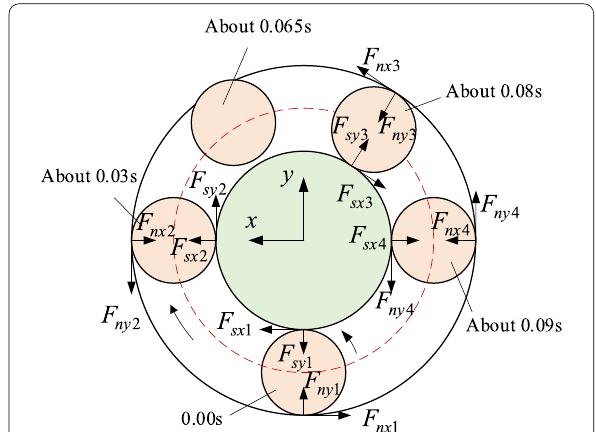
Figure 29 Contact force analysis of roller 7 during 0.1 s